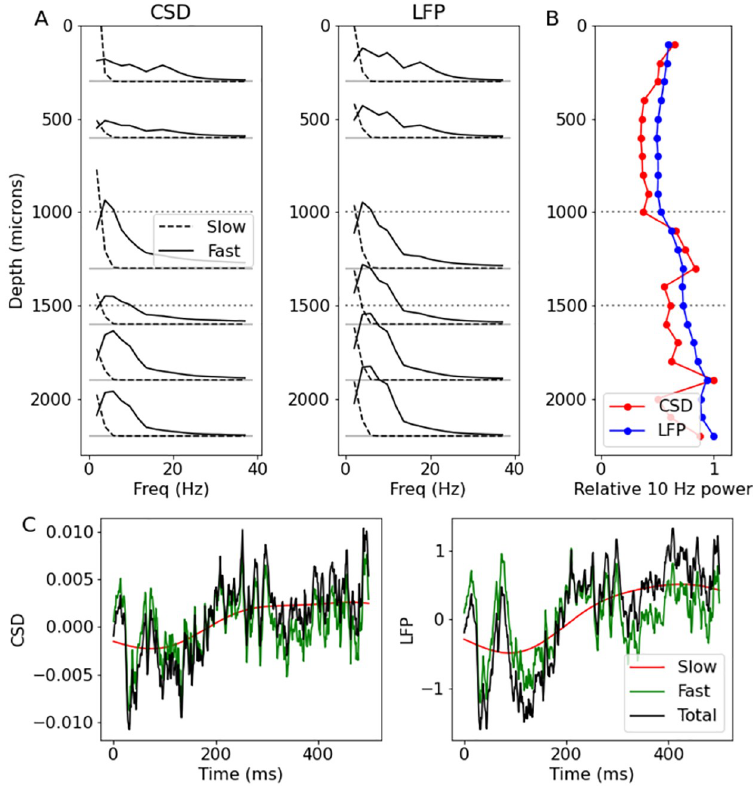
Fig 2. Spatial, spectral, and temporal properties of LFP and GPCSD. (A) Periodograms (averaged across trials) showing power spectra at six cortical depths along the lateral probe for CSD (left) and LFP (right), computed for estimated fast-timescale processes (solid) and slow-timescale processes (dashed). Horizontal grey dotted lines indicate approximate boundaries between superficial, medium, and deep cortical layers. (B) Relative 10Hz power for CSD (red) and LFP (blue) as a function of cortical depth. (C) Time courses for a single trial for an electrode in the middle cortical layers, broken into slow, fast, and total, for CSD (left) and LFP (right). While the temporal components were similar in LFP and CSD, they did exhibit differences due to the different spatial properties of the